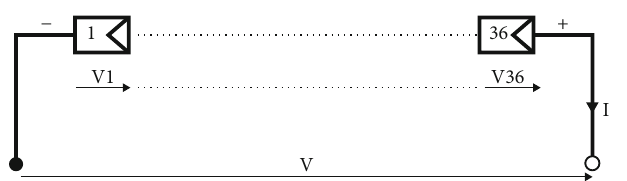
Figure 2: Synoptic diagram of the PV